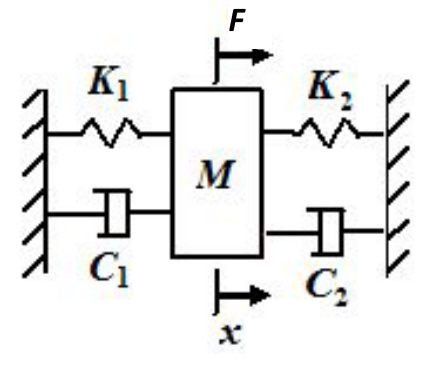
Figure 9. One dimensional spring mass